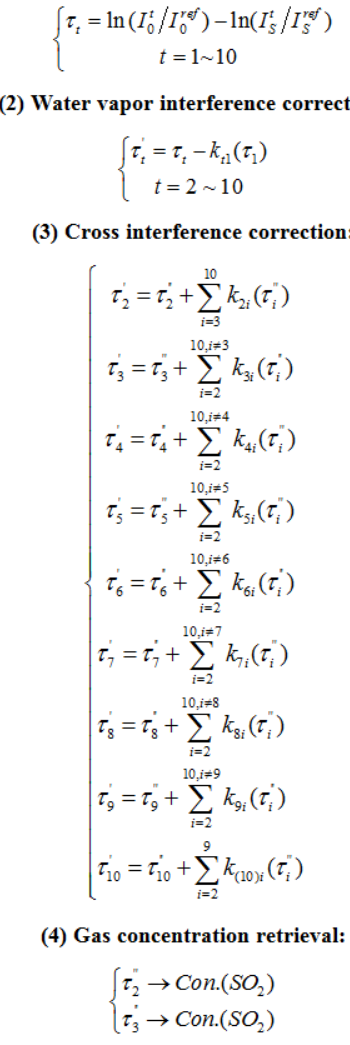
Figure 3. Four steps for SO 2 concentration retrieval. The instru- ment measures intensities of all channels. Measurement values are converted into absorbance and corrected for water vapor interfer- ence using the water vapor channel. Cross-interference corrections are performed using interference equations. Corrected absorbances are finally converted into SO 2 concentrations. See text for further